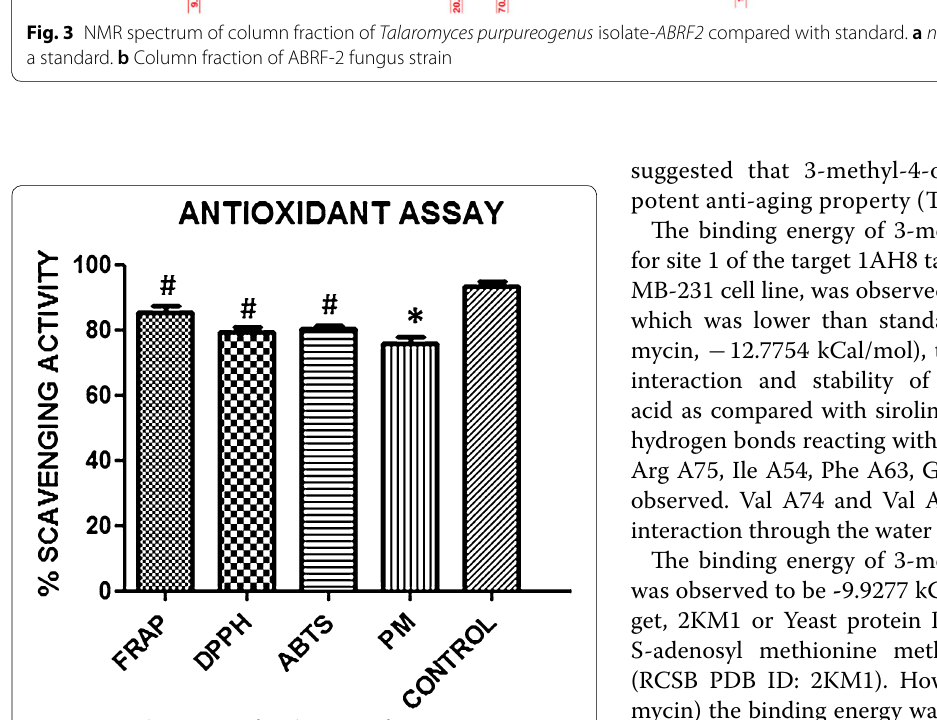
Fig. 4 Antioxidant activity of crude extract of T. purpureogenus isolate- ABRF2 in YESB (yeast extract sucrose broth) nutrient medium. Ascorbic acid was used as positive control. One-way analysis of variance (ANOVA) followed by Tukey’s multiple comparison test. Sample with p < 0.05 were considered significant p < 0.05 and ≠ p <